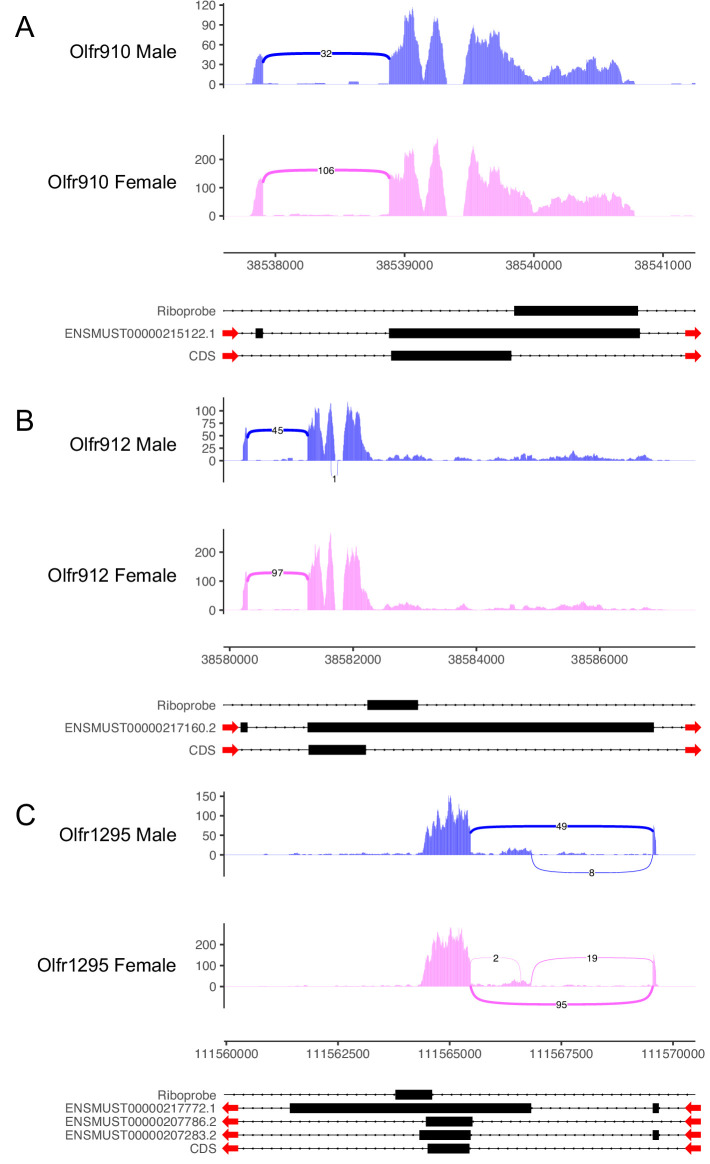
Architecture of reads uniquely mapping to female-enriched ORs.(A) Architecture of reads uniquely mapped to Olfr910 in male and female mice. Shown are the defined transcript variants, coding sequence (CDS), uniquely designed riboprobe, and 5′ to 3′ directionality (red arrows). The y-axis shows the number of mapped reads along genomic coordinates described on the x-axis. Reads crossing exon junctions are also quantified. (B) Architecture of reads uniquely mapped to Olfr912. (C) Architecture of reads uniquely mapped to Olfr1295.